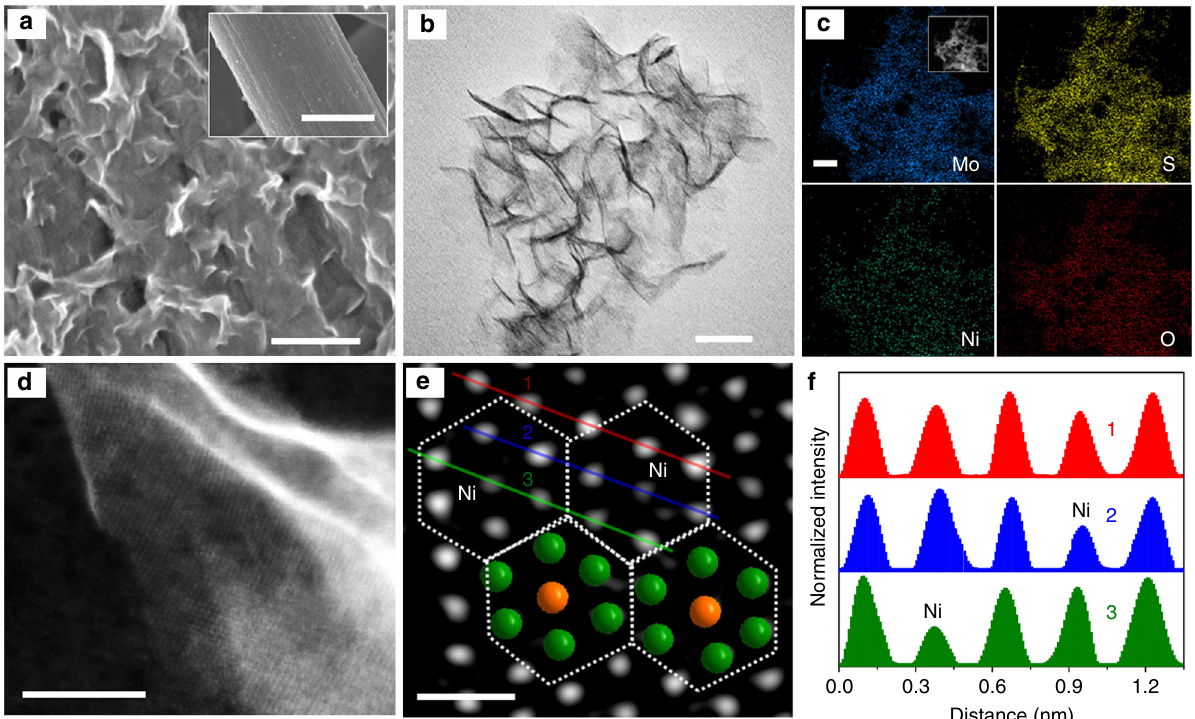
Fig. 2 Structure characterizations of NiO@1T-MoS 2 . a SEM image, scale bar: 200 nm (inset: low magni fi cation SEM image, scale bar: 5 μ m). b TEM image (scale bar: 20 nm). c EDX mappings (scale bar: 1 μ m). d High-angle annular dark- fi eld (HAADF) STEM image (scale bar: 5 nm). e Aberration-corrected atomic resolution HAADF-STEM image (scale bar: 0.5 nm). The white dotted hexagons show the NiMo 6 units in NiO@1T-MoS 2 (green: Mo; orange: Ni). f Intensity pro fi les along the lines indicated in image e